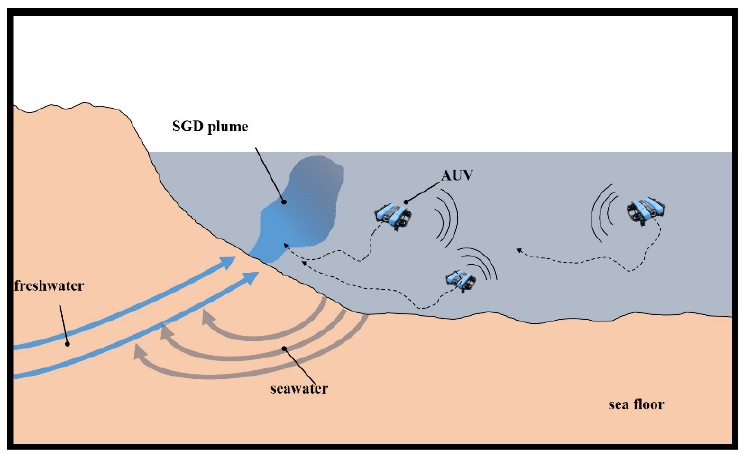
Figure 1. Principal concept of the proposed submarine groundwater discharge (SGD) search utilising a swarm of autonomous underwater vehicles (AUVs).